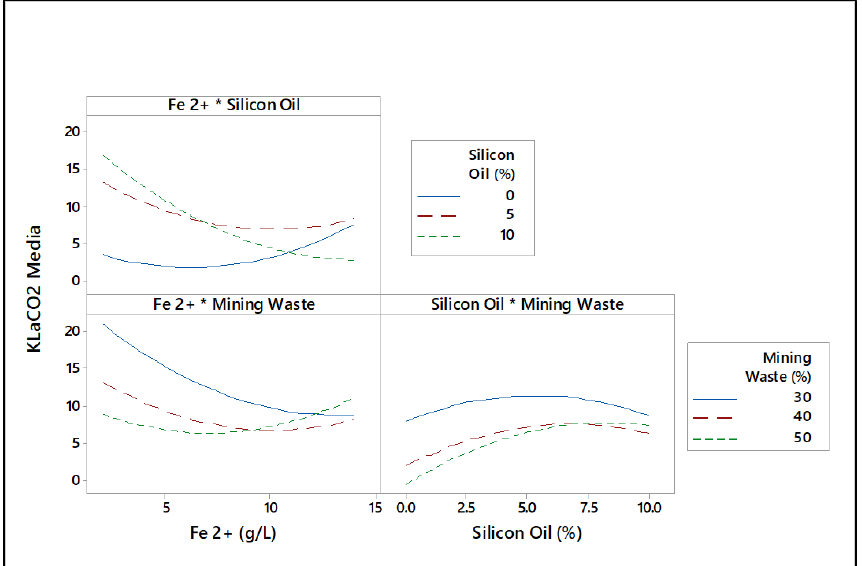
Figure 3. Interaction plot (adjusted media) between silicone oil – mining waste – ferrous sulfate. Crossing between parameters indicates an interaction concerning the response ( k LaCO2 ).